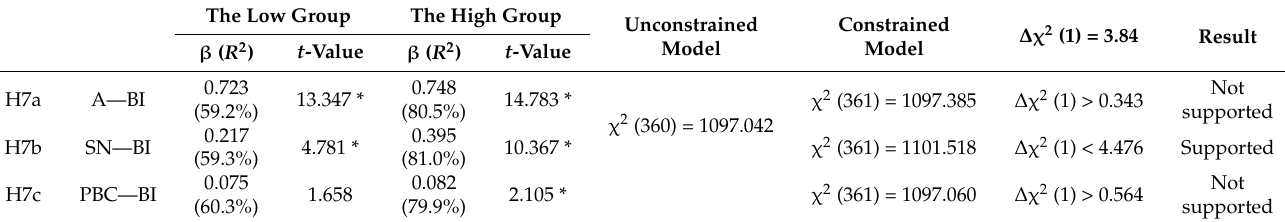
Table 4. Results for the moderating role of product